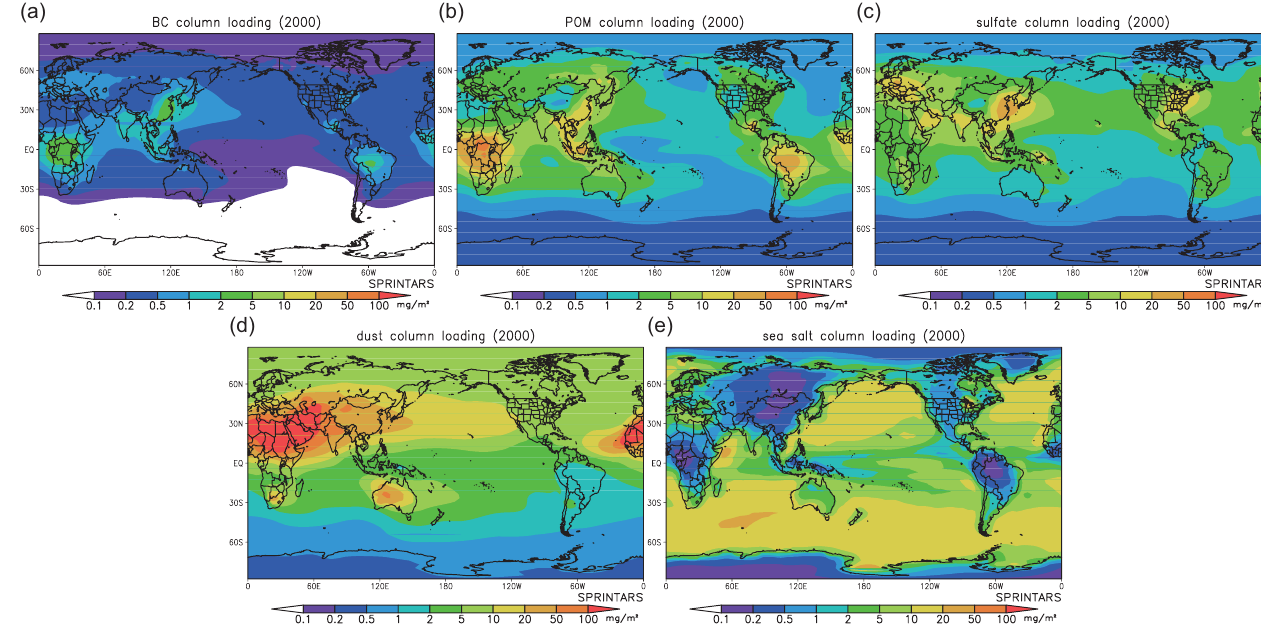
Fig. 3. Global distributions of mass column loadings of (a) BC, (b) POM, (c) sulphate, (d) soil dust, and (e) sea salt in 2000 (averaged over the period 1998–2002) simulated by